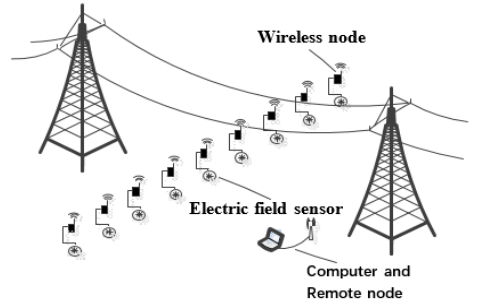
Figure 7. Arrangement diagram of electric-field measurement system.